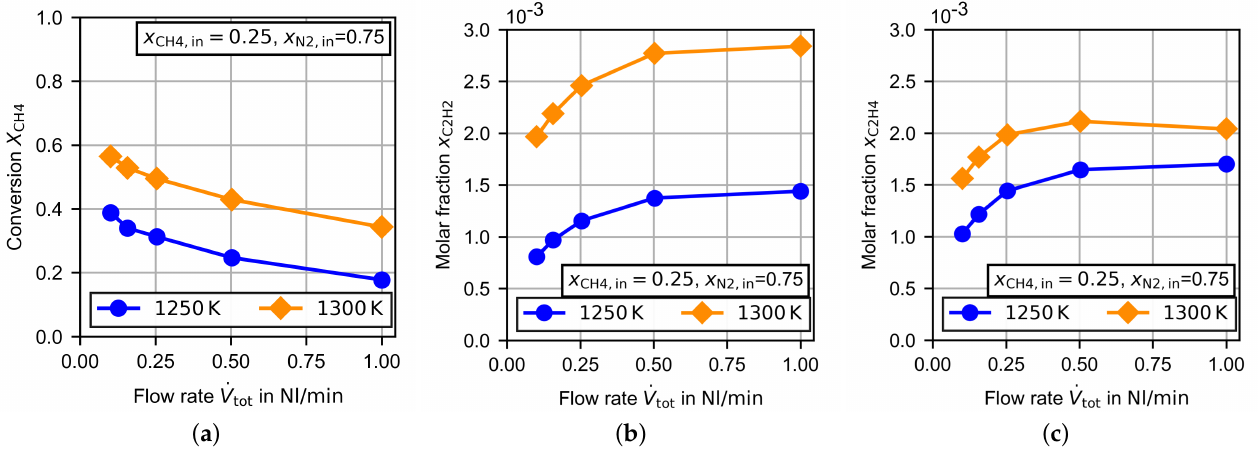
Figure 5. Experimental results for the TDM dependent on the flow rate at 1250 and 1300K. ( a ) Methane conversion, ( b ) molar fraction of acetylene and ( c ) molar fraction of ethylene.